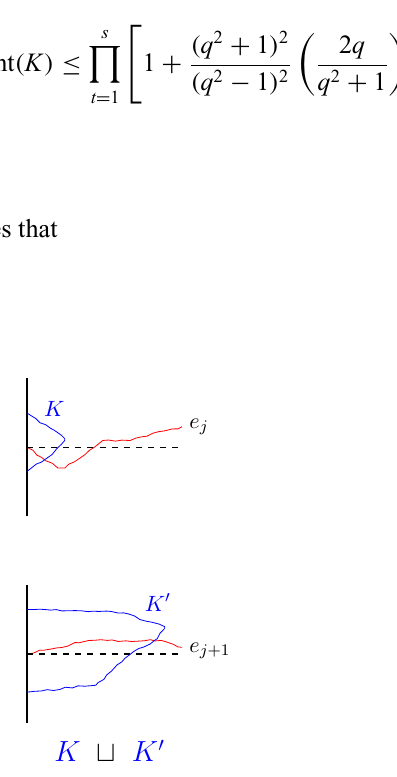
FIG. 7. The outline of the argument in the proof of Lemma 4 that the sum over domain-wall trajectories in J H , j is at least the sum divided by some constant factor, expressed in Eq. (D38). Every trajectory in J (cid:12) ∈ J (cid:12) in J (cid:12) H , j ,0 J ∈ J H , j a trajectory K ∈ B H , j , and a trajectory K (cid:12) ∈ B H , j + 1 , where each domain wall in K intersects the j th domain wall of H , and each domain wall of K (cid:12) intersects the ( j + 1 ) th domain wall of H . Because the combined weight of all possible K and K (cid:12) is only a constant factor, independent of n , the combined weight of all possible J cannot be more than a constant factor smaller than the combined weight of all possible J (cid:12) . Note that the system with X sites has periodic boundary conditions in this